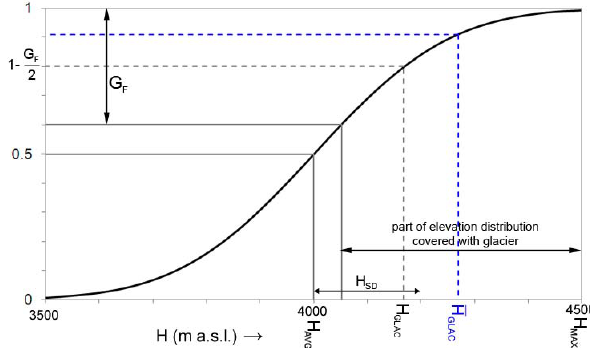
Fig. 5. Distribution of terrain elevation within a 1km grid cell. H AVG is the mean terrain elevation in a 1km grid cell. H SD is the standard deviation of the terrain elevation distribution. G F is the fractional glacier cover for a 1km grid cell. H GLAC is the obtained median elevation for the part of the grid cell covered with ice. In this figure G F = 0 . 4, H AVG = 4000ma.s.l. and H SD = 200m. Equa- tion (1) yields H GLAC = 4168ma.s.l. During the simulation an up- dated value for G F is calculated using H GLAC and Eq. (10). In this example H GLAC = 4270ma.s.l. With H AVG = 4000ma.s.l. and H SD = 200m for this grid cell, Eq. (10), yields G F = 0 .